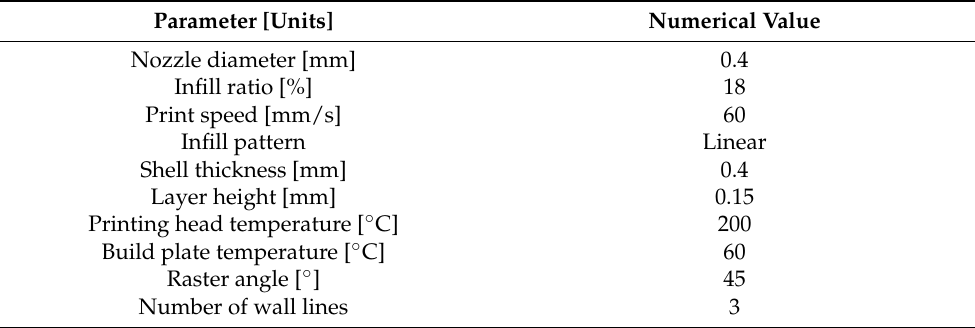
Table 2. Main 3D-printing parameters for the cams.